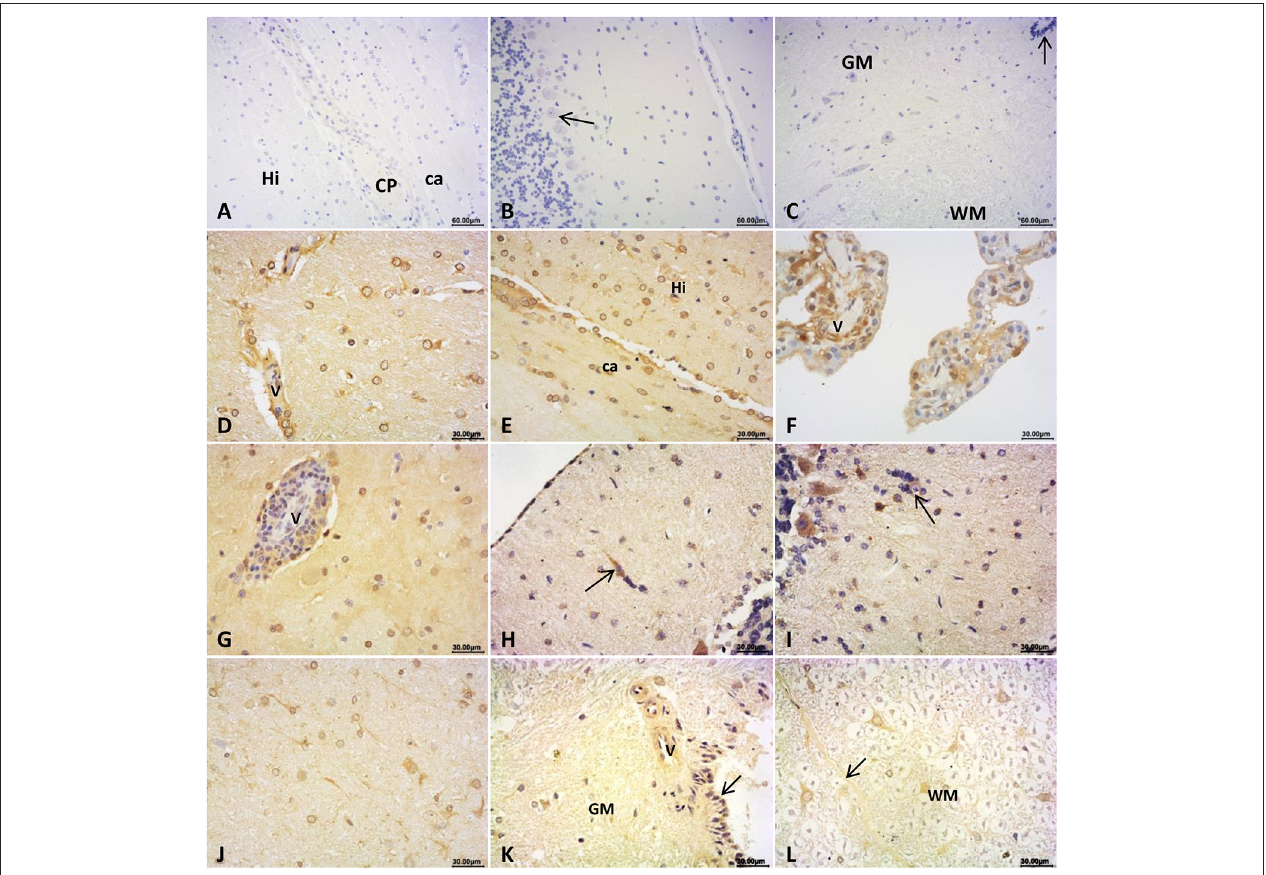
FIGURE 2 | Immunohistochemical staining for HEV ORF2 antigen. (A–C) ORF2 positive signals was not detected in brain and spinal cord of the control rabbits: cerebrum (A) hippocampus and white matter area (Hi: hippocampus, CP: choroid plexus, ca: corpus callosum), cerebellum (B) the molecular layer and granular layers, and pukinje cells, spinal cord (C) the gray matter (GM) and white matter (WM), arrow showed central canal of the spinal cord. In brain detected as HEV RNA positive, HEV ORF2 protein expression distributed at: (D–G) cerebrum, (D) perivascular area and cytoplasm of glial cells of the white gray, (E) cytoplasm of glial cells in corpus callosum (ca) and hippocampus (Hi) of the white matter, (F) cytoplasm of choroid epithelium cells, and (G) lymphocytes in perivascular area and glial cells cytoplasm of the gray matter; (H–I) cerebellum, (H) Pia Mater and neurons invaded by microglial cells, (I) cytoplasm of pukinje cells and cells that formed microglial nodules (arrow); (J) cytoplasm of neurons and glial cells in white matter of pons; (K,L) spinal cord, (K) perivascular area and epithelial cells of central canal of the gray matter, (L) posterior septum (arrow) of spinal cord and cytoplasm of neurons in white matter